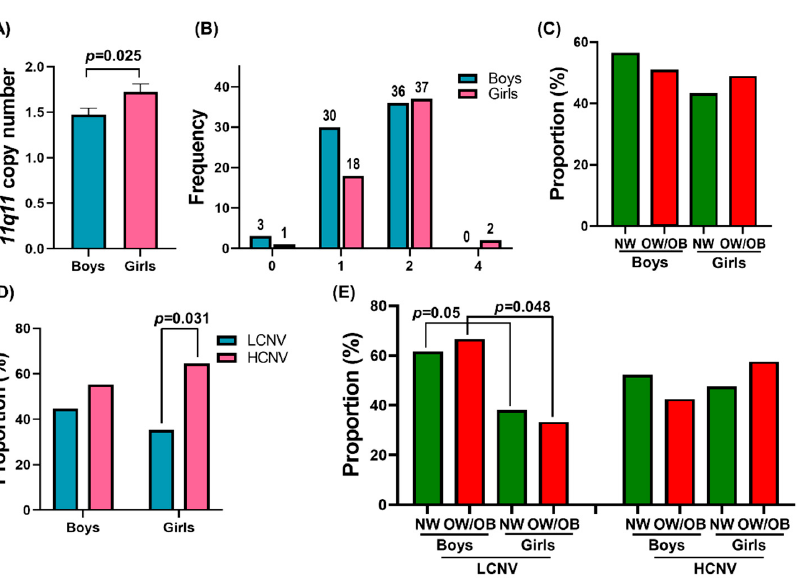
Figure 2. 11q11 copy number in White/European American (EA) and African American (AA) children. ( A ) The bar graphs represent the mean 11q11 copy number differences between EA and AA participants. ( B ) Distribution of 11q11 copy number in the study population by race. ( C ) The proportions of participants with NW and OW/OB in EA and AA. ( D ) The proportions of low and high CNV among EA and AA. ( E ) The proportions of NW and OW/OB in EA and AA, with LCNV and HCNV.